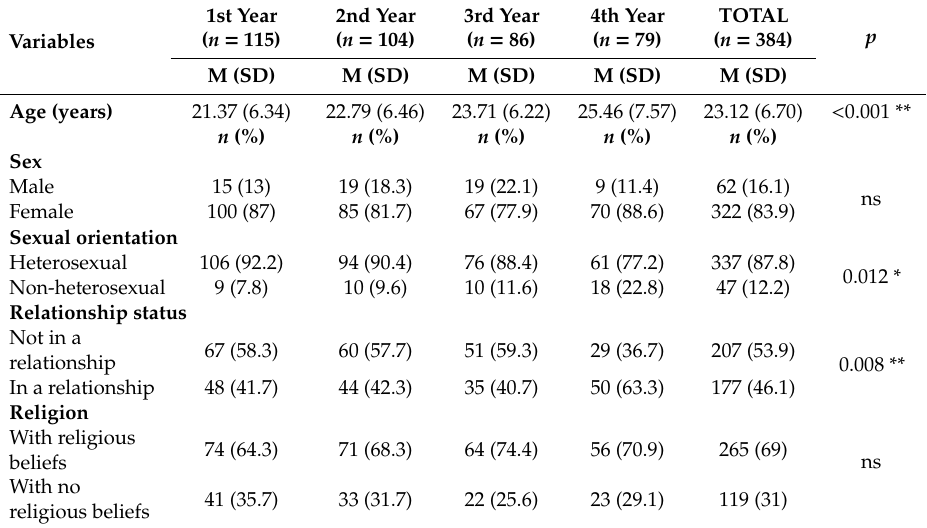
Table 1. Sociodemographic variables of the sample according to academic year.